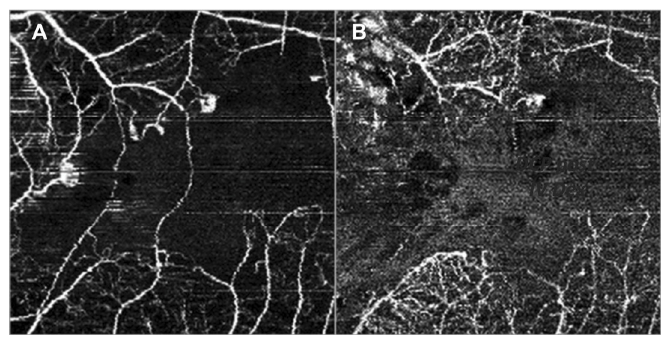
Figure 13. OCTA imaging of the superficial ( A ) and deep ( B ) capillary plexuses showing capillary dropout.